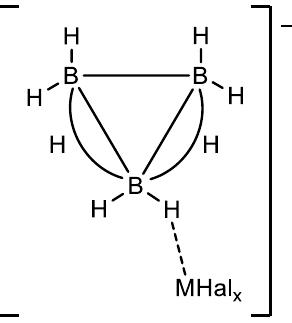
Figure 1. Possible structure of the transition complex [B 3 H 7 -HMHal x ] − .